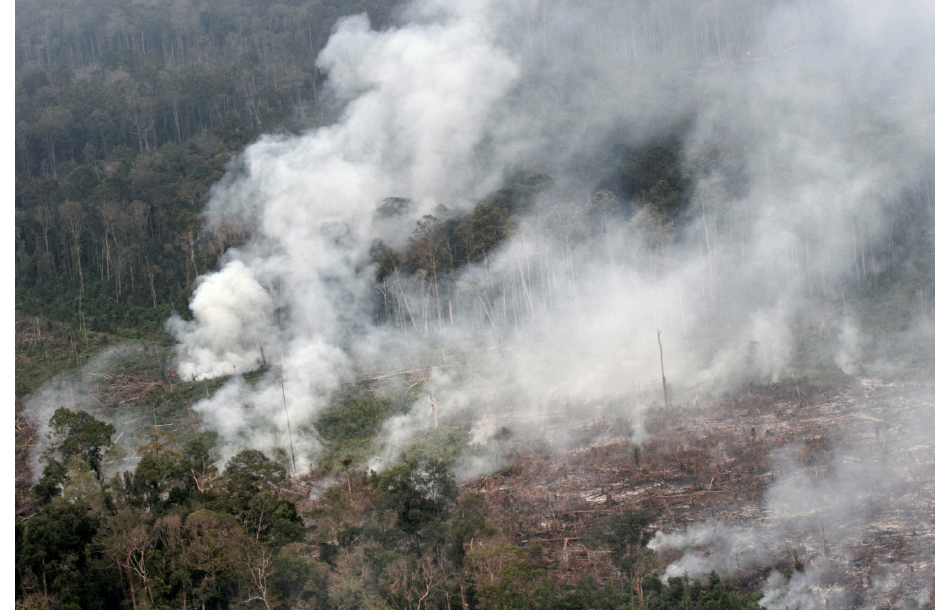
Figure 3. A destructive forest fire near Riau in central Sumatra, Indonesia (photograph by William Laurance).